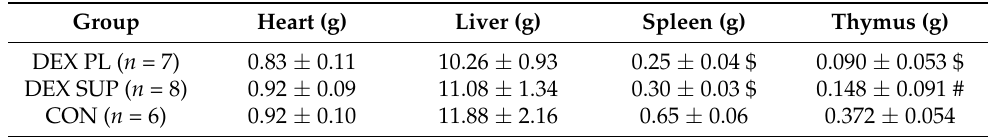
Table 6. Internal organ mass at the end of the experiment in DEX-treated rats. Group Heart (g) Liver (g) Spleen (g) Thymus (g) DEX PL ( n =